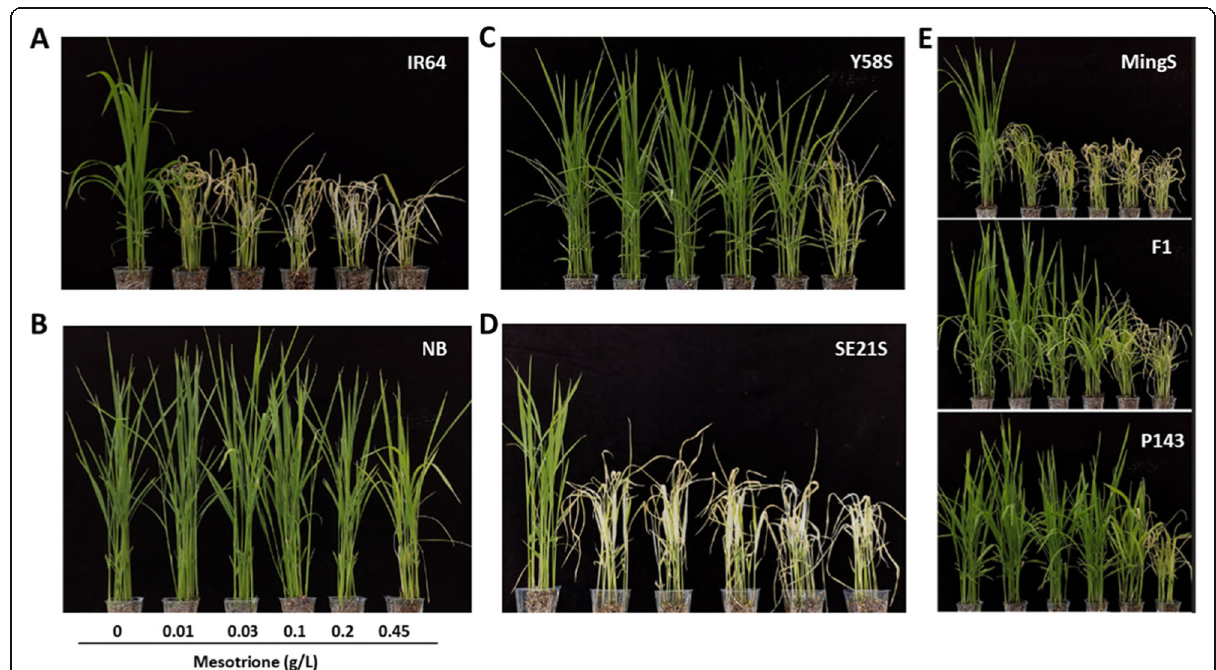
Fig. 6 Potential applications of mesotrione in improving the seed purity of 2-line hybrid rice. a – d Concentration-dependent effects of mesotrione on IR64, Nipponbare (NB), Y58S, and SE21S. e Concentration-dependent effects of mesotrione on the 2-line hybrid variety Mingliangyou143 (F1), female parent MingS, and male parent